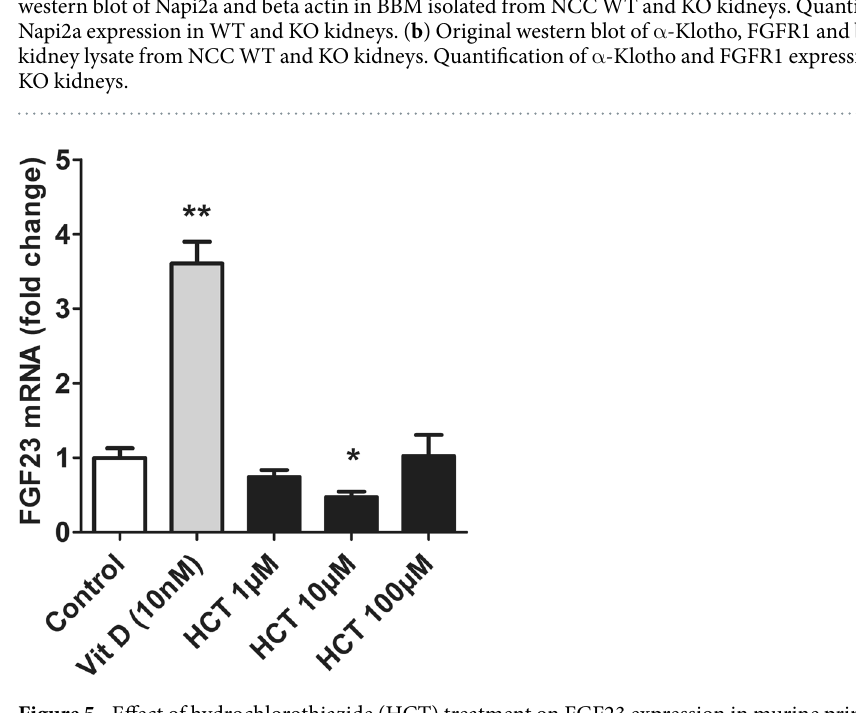
Figure 5. Effect of hydrochlorothiazide (HCT) treatment on FGF23 expression in murine primary osteoblast. Arithmetic means ± SEM (n = 5–6) of FGF23 mRNA levels in murine primary osteoblasts following treatment with vehicle (ethanol; control), 10 nM 1,25(OH) 2 D 3 or 1, 10, 100 μ M HCT. * (p < 0.05) for ctrl vs 1,25(OH) 2 D 3 , HCT 1, 10, 100 μ M. FGF23 transcript levels are expressed relative to the level of the GAPDH control